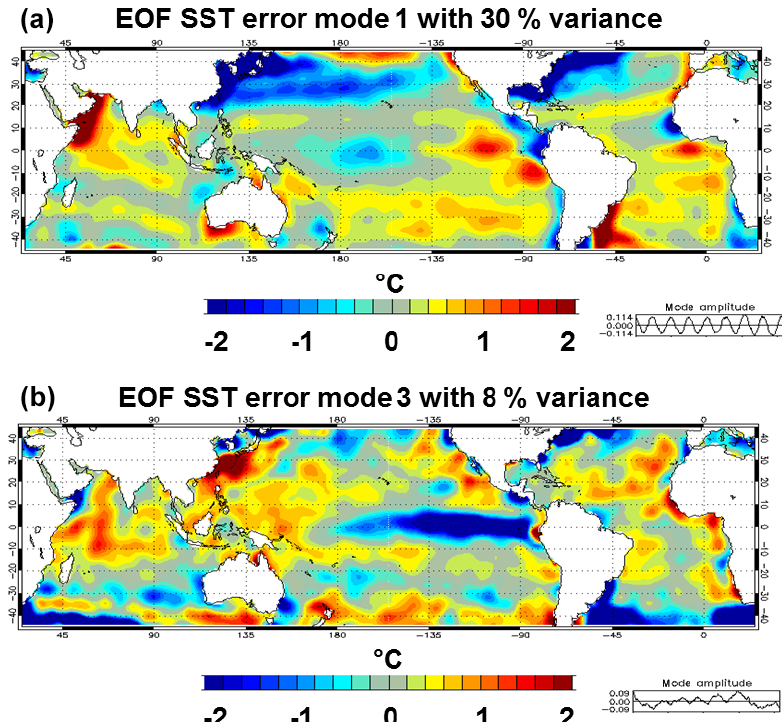
Figure 19. First EOF (a) and third EOF (b) of sea surface temperature observation error ( ◦ C) over the 2007–2015 time period. The time series at the bottom of each panel correspond to the mode